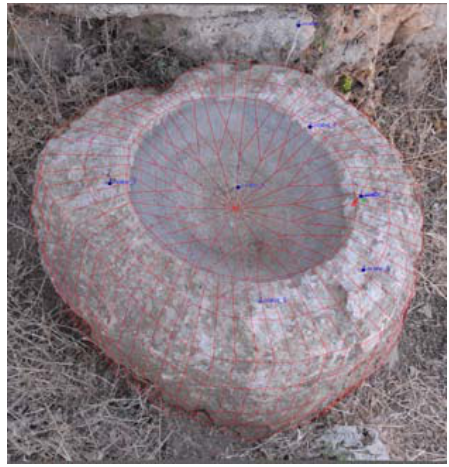
Figure 20. Te 3D model of the basin in court